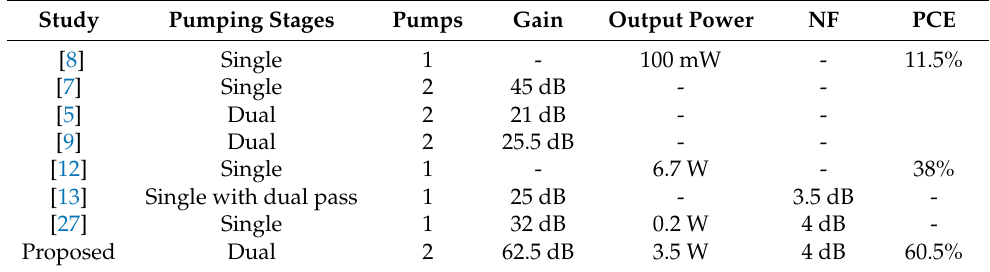
Table 3. Comparison of the important results of the proposed work with results of the past re- lated